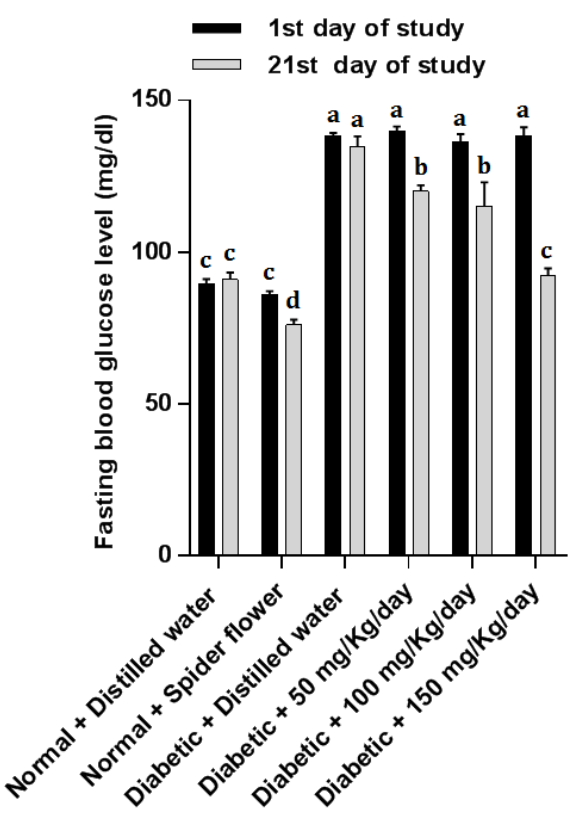
Figure 2. The effect o f Ballota stem s extract on fasting bloo d glucose level i n normal a nd n5-STZ diabeti c mice; * The groups from left to right are the same groups mentioned in (Table 1) from Group I –